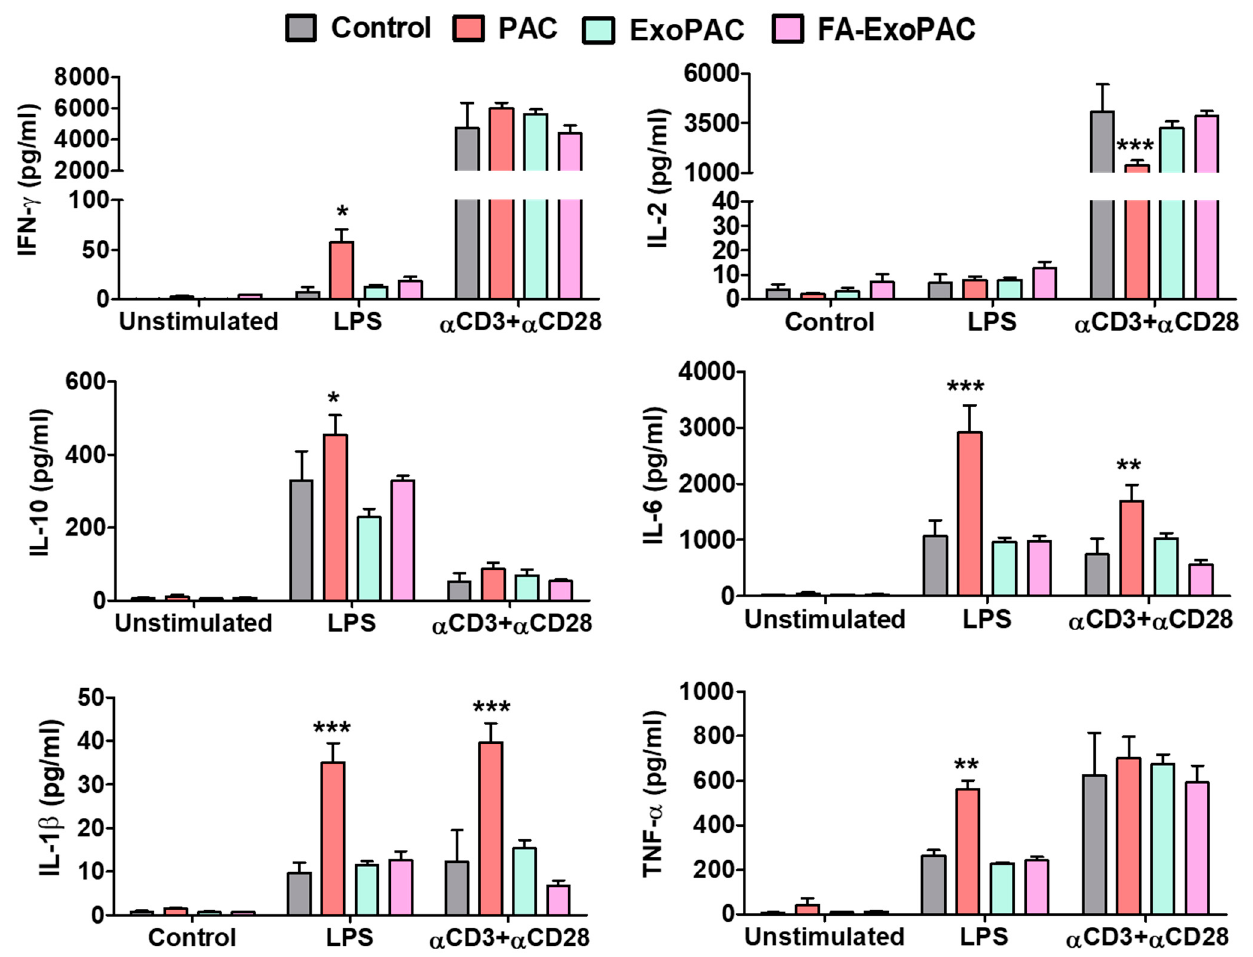
Figure 8. Potential immunotoxicity of PAC and FA-ExoPAC. Female C57BL/6 mice were treated with Exo, PAC and FA-ExoPAC for four weeks. At euthanasia, spleen and bone marrow cells were collected. Splenic cells were treated with the different stimulant for 24 h. Sups were collected and MesoScale analysis (V-PLEX of 6 cytokines) was performed. LPS was used for B-cell response and α CD3+ α CD28 for T-cell response. All statistical analysis was performed by two-way ANOVA and compared with untreated control. *, p < 0.05; **, p < 0.01; ***, p < 0.001.